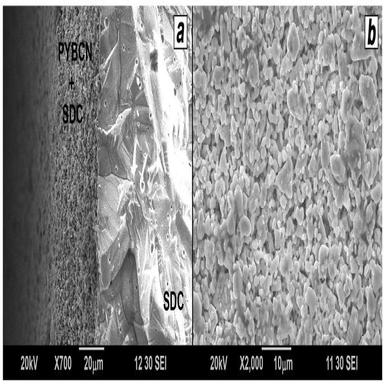
The micrographs of the electrolyte with the deposited dual-phase composite PYBCN/SDC electrode (a) and the surface of the porous electrode (b).